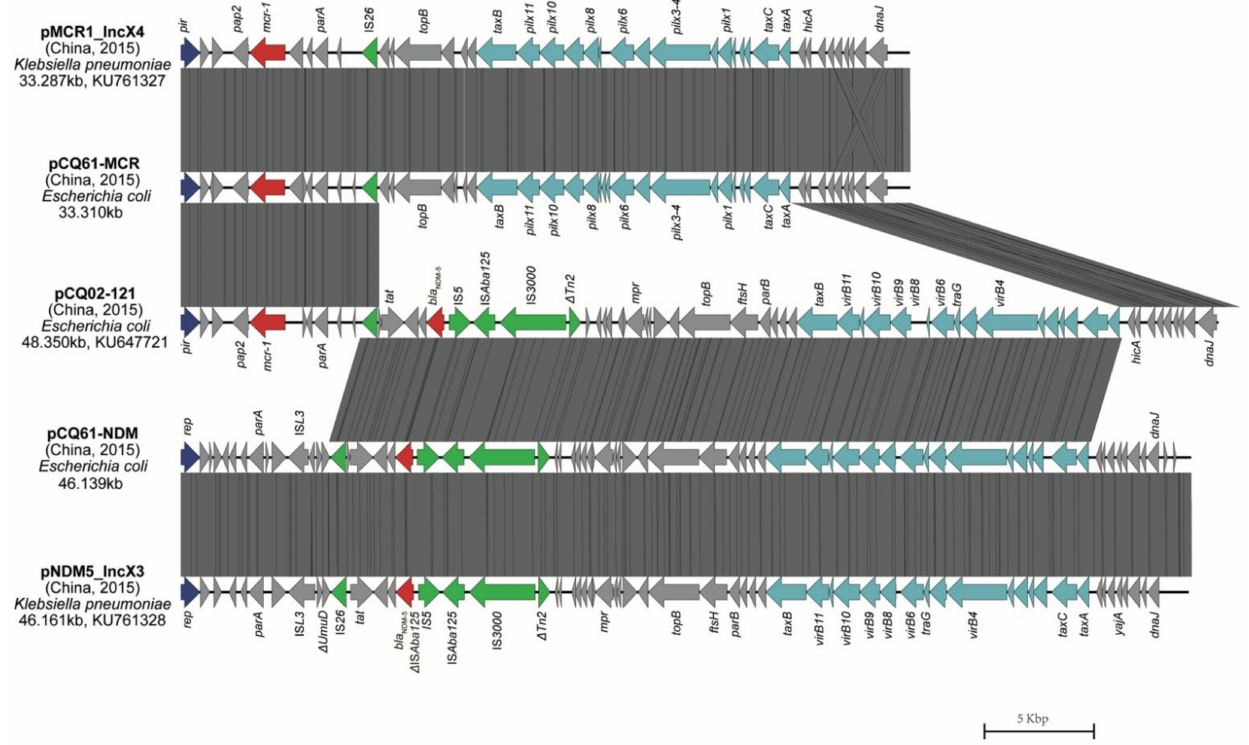
Figure 4. Linear sequence comparisons of pCQ61-NDM and pCQ61-MCR with other plasmids, including pMCR1_IncX4 (GenBank Acc. no. KU761327), pNDM5_IncX3 (GenBank Acc. no. KU761328) and from our previous study pCQ02-121 (GenBank Acc. no. KU647721). Boxed arrows represent the position and transcriptional direction of ORFs (open reading frames). Regions of >99% identity are marked by grey shading. Dark blue represents replication-associated genes, and light blue represents genes associated with the pil , tra and vir loci. ARGs are colored red; insertion sequences are colored